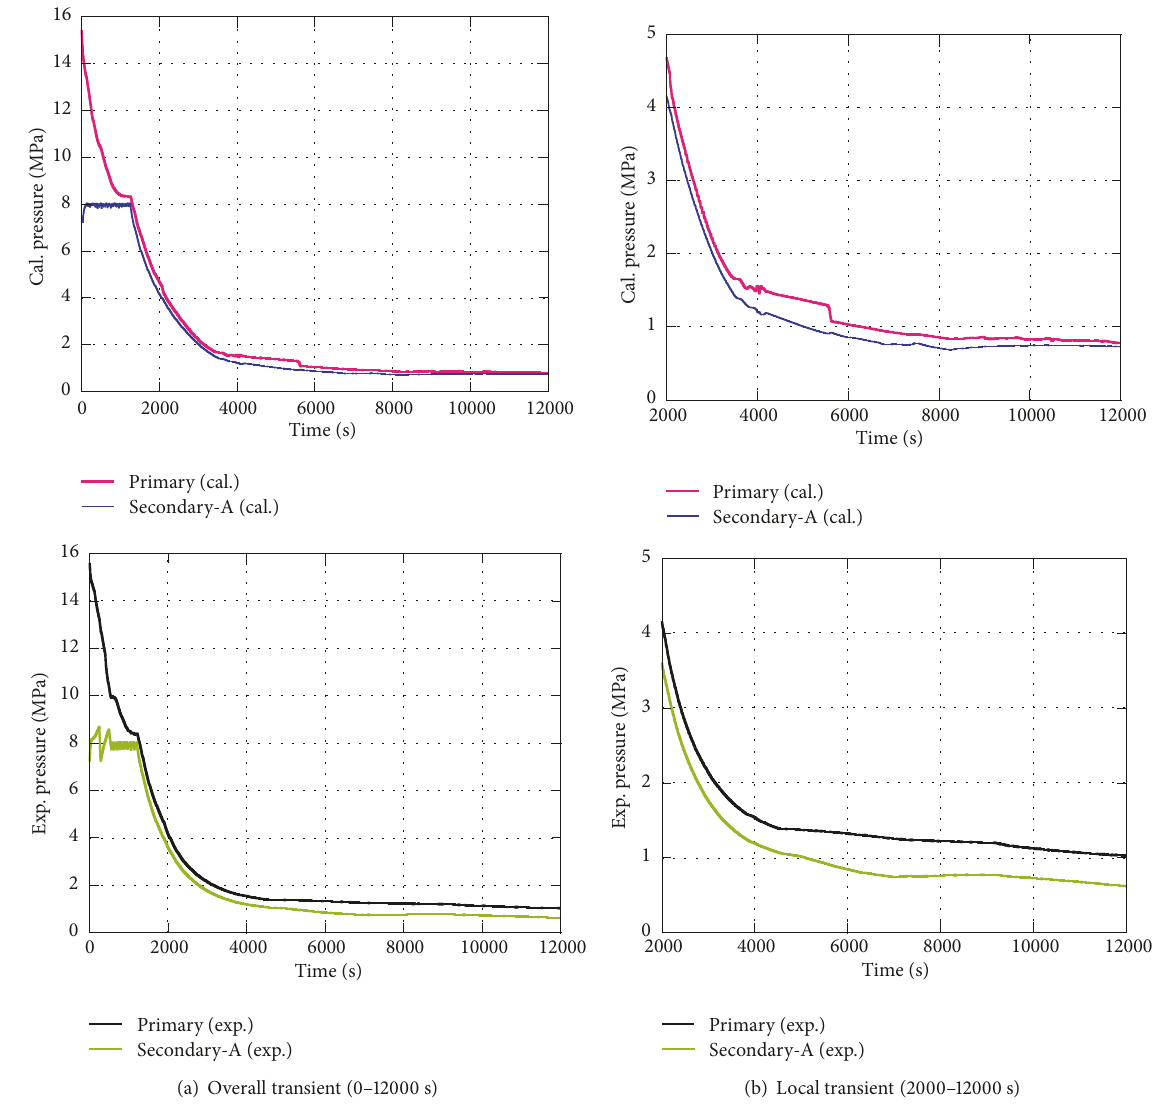
Figure 15: TR-LF-17 test and RELAP5 results for primary and SG secondary-side pressures in loop